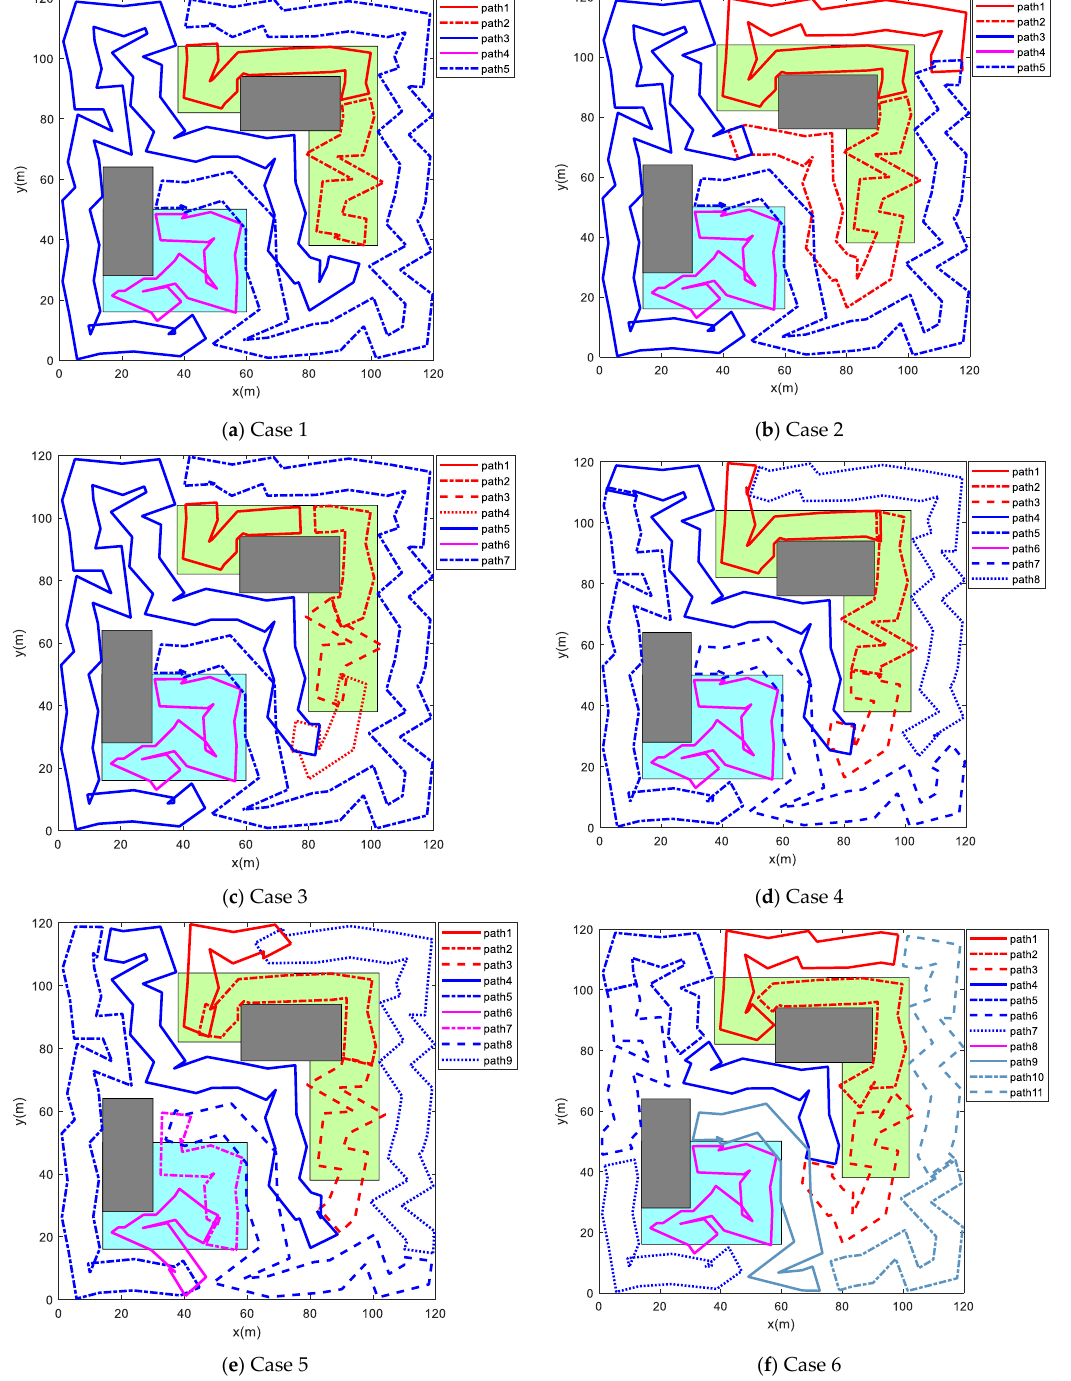
Figure 14. Simulation results under different coverage period constraints.